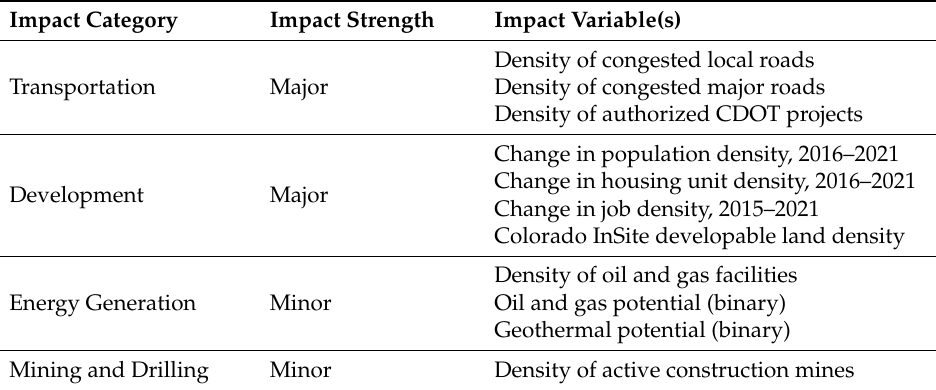
Table 4. Characterizing future demand for stream mitigation based on